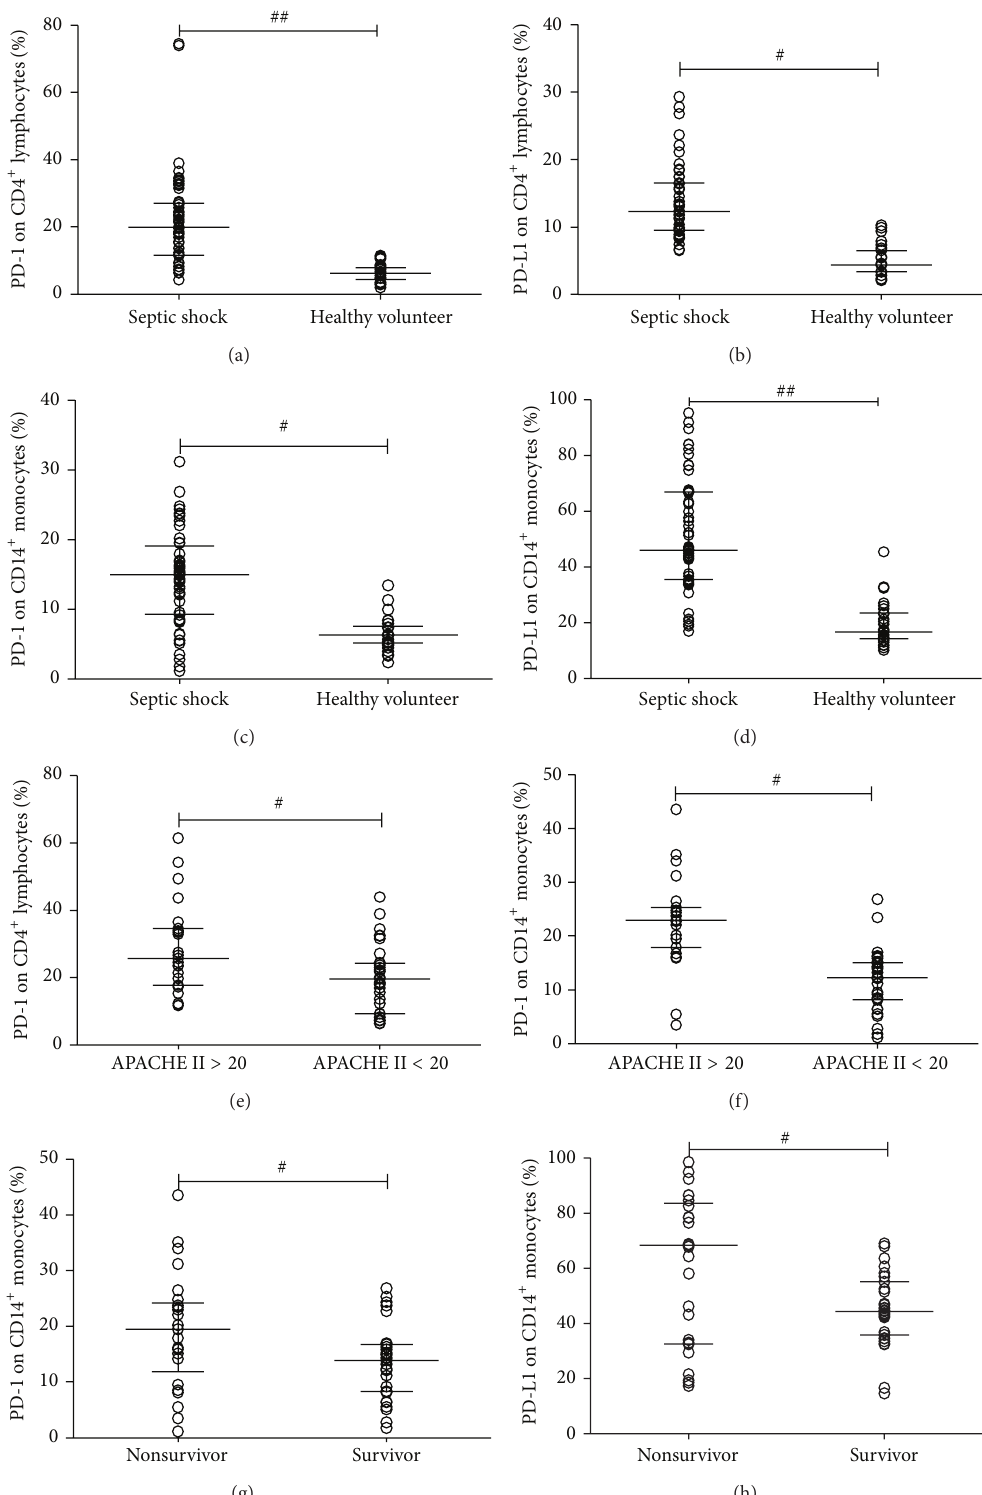
Figure 1: Expressions of PD-1/PD-L1 on CD4 + T cells and monocytes in early-stage septic shock patients. Percentages of PD-1 and PD-L1 expressions on CD4 + T cells and monocytes were compared between septic shock patients ( 𝑛 = 56 ) and healthy volunteers ( 𝑛 = 30 ): (a) percentage of PD-1 expression on CD4 + T cells; (b) percentage of PD-L1 expression on CD4 + T cells; (c) percentage of PD-1 expression on monocytes; (d) percentage of PD-L1 expression on monocytes. The percentages of PD-1 expression on CD4 + T cells (e) and monocytes (f) were compared between patients with APACHE II scores > 20 ( 𝑛 = 22 ) and < 20 ( 𝑛 = 34 ). These expressions on monocytes were also compared between survivors ( 𝑛 = 31 ) and nonsurvivors ( 𝑛 = 25 ): (g) percentages of PD-1 expression; (h) percentages of PD-L1 expression. Each dot represents one individual value. Analyses were conducted using the Mann-Whitney rank sum test. # 𝑃 < 0.05 , ## 𝑃 < 0.01